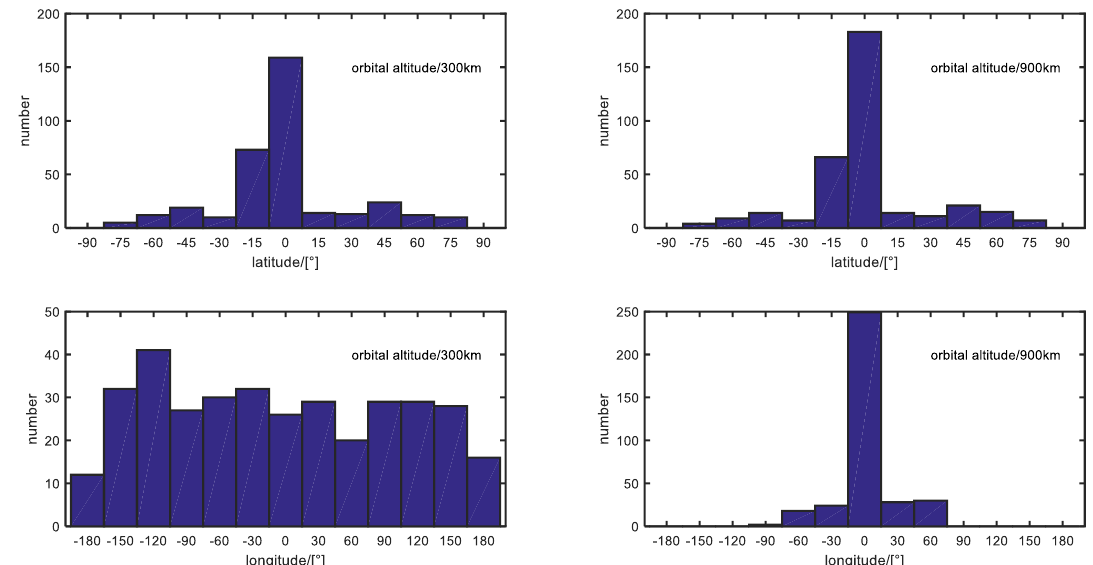
Figure 6. Changes in latitudinal and longitudinal coverage with orbital altitude.